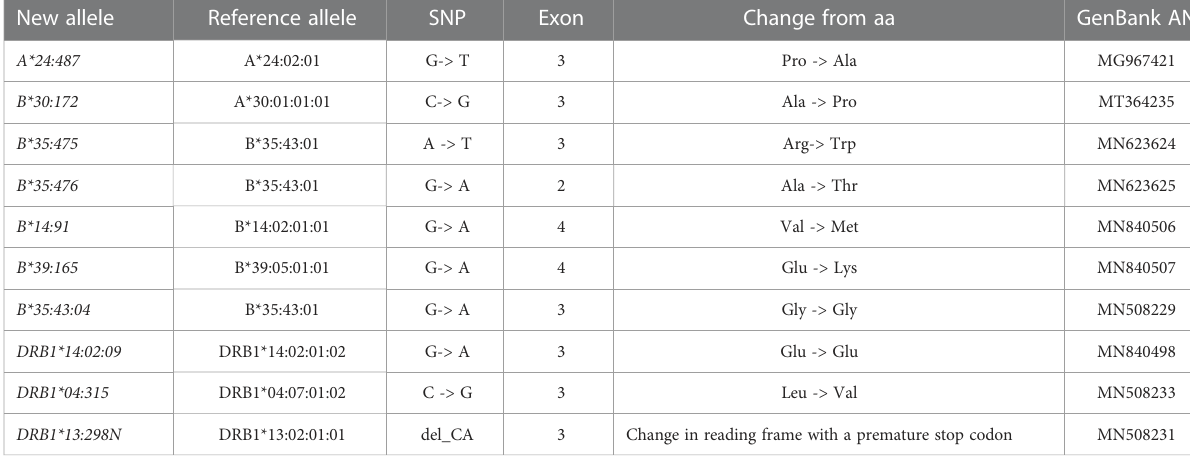
TABLE 5 New HLA alleles submitted currently.